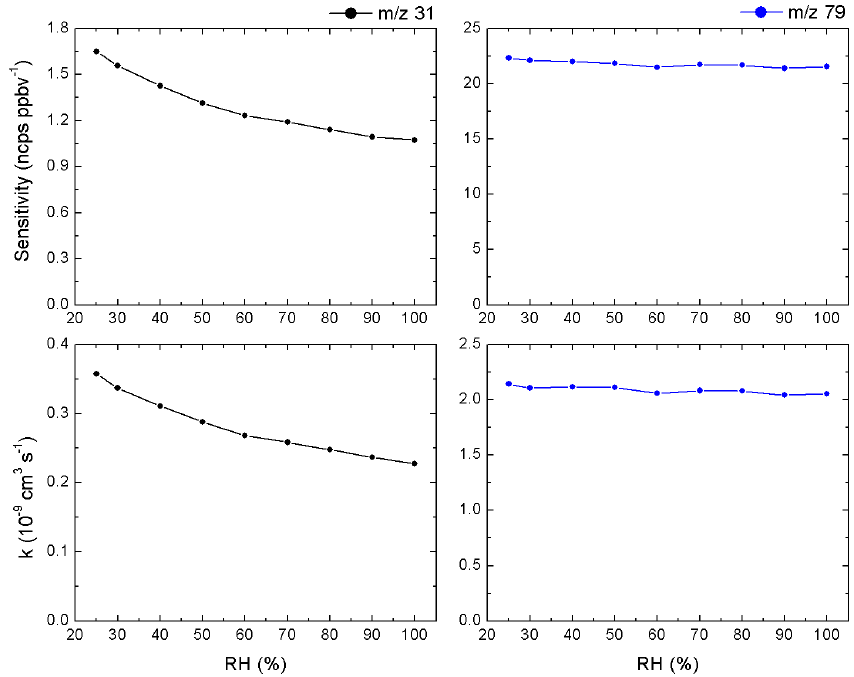
Figure 2. The effect of ambient RH on sensitivity and experimental k value of HCHO ( m/z 31) and benzene ( m/z